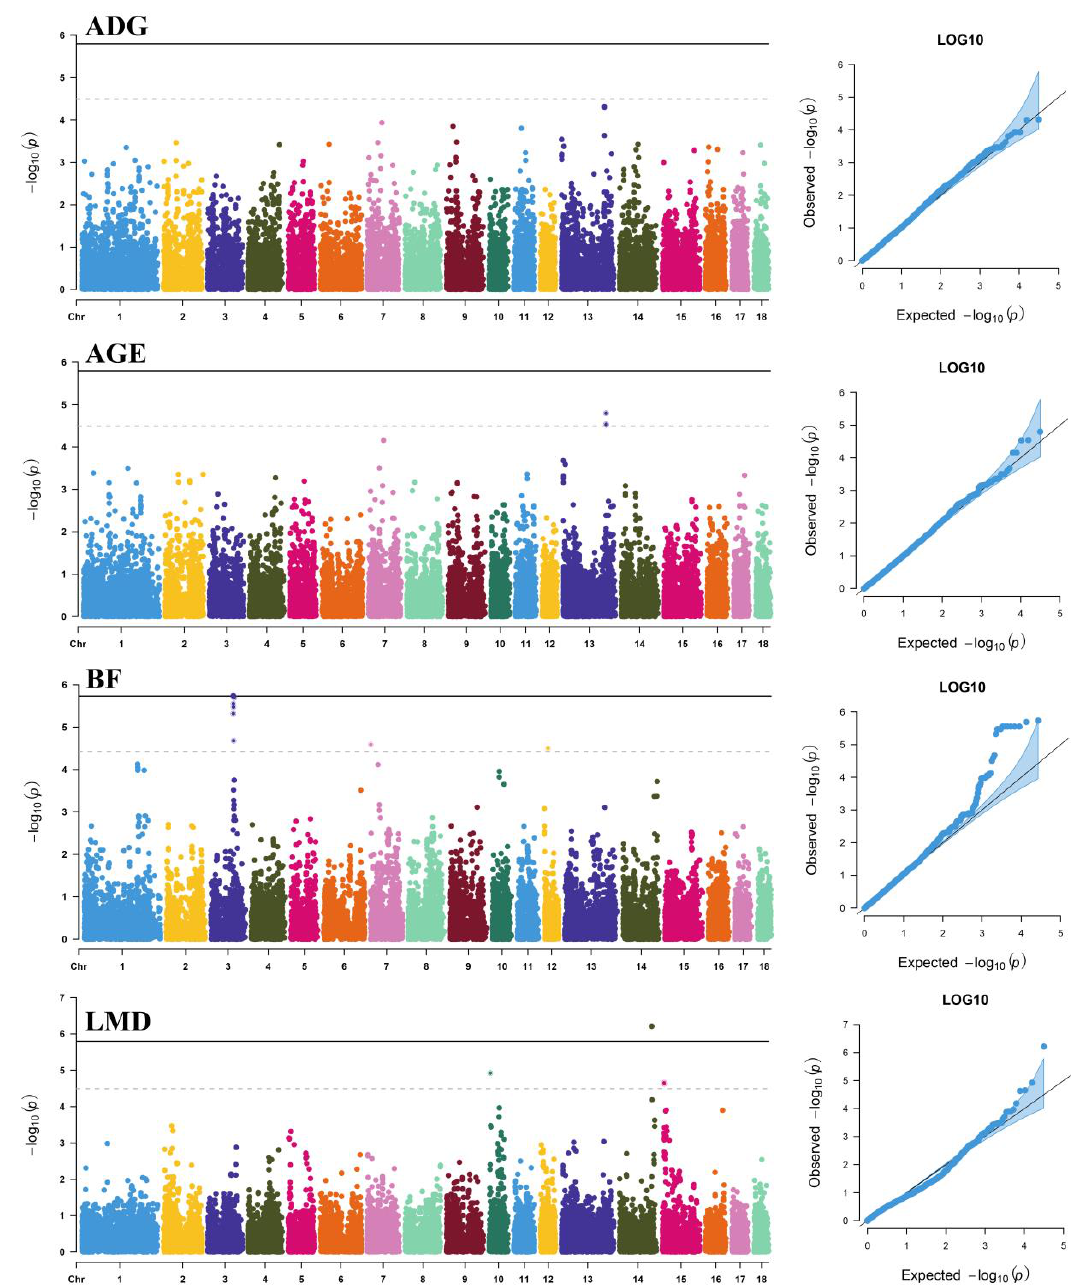
Figure 2. Manhattan plots and Q - Q plots of SNP dominance effects for average daily gain (ADG), adjusted age at 100 kg (AGE), backfat thickness at 100 kg (BF), and loin muscle depth at 100 kg